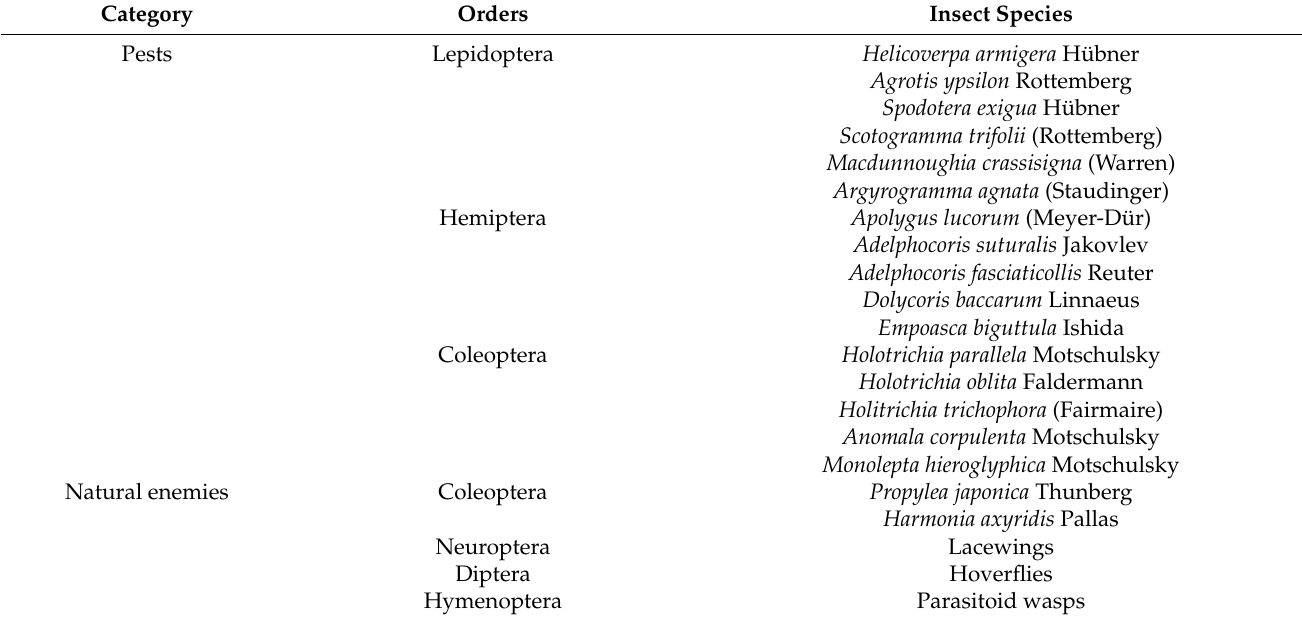
Table 1. Insect species surveyed in the LED traps with 19 single wavelengths during